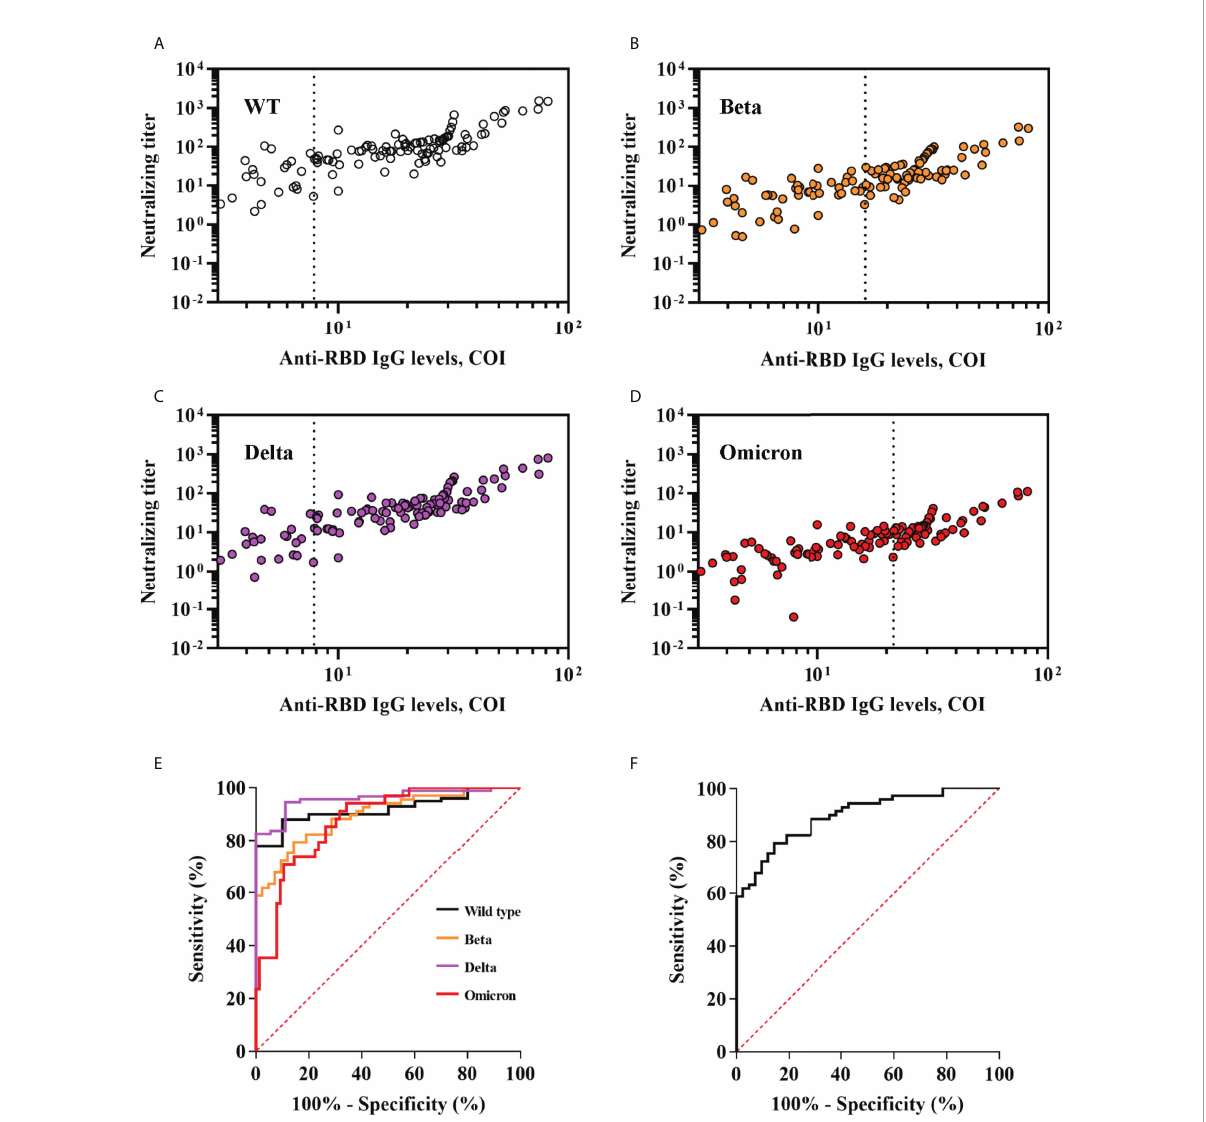
FIGURE 5 Performance of anti-RBD IgG levels in predicting neutralization titer and breadth of SARS-CoV-2 variants. (A – D) Anti-RBD IgG levels were plotted against neutralization of wild-type and variants of SARS-CoV-2. Optimal anti-RBD IgG cut-offs for predicting positive neutralization were determined by ROC analyses in (E) and are indicated with a vertical dashed line. (E) ROC analyses assessing the ability of anti-RBD IgG levels to predict neutralization titers against wild-type and variants of SARS-CoV-2. Positive neutralization titer was de fi ned as ≥ 10. (F) ROC analyses assessing the ability of anti-RBD IgG levels to predict neutralization breadth. Broad neutralization breadth was de fi ned as ≥